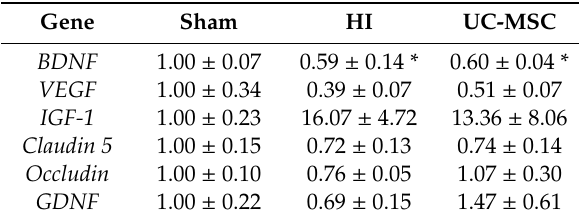
Table 1. Gene expression in injured left hemisphere as measured by RT-PCR. Gene Sham